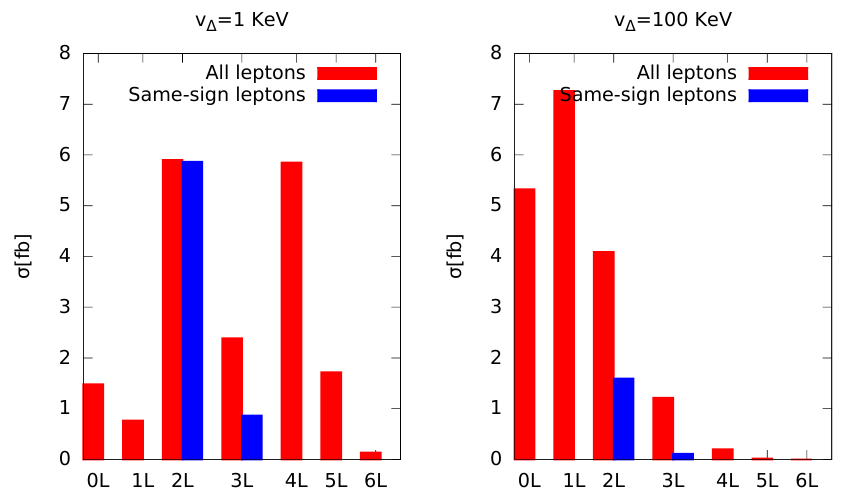
Figure 15 . Lepton multiplicity distribution after imposing the acceptance cuts summarized in eqs. (3.7){(3.9). We have considered m (cid:1) = 500 GeV. Left panel corresponds to small v (cid:1) and right panel corresponds to large v (cid:1)